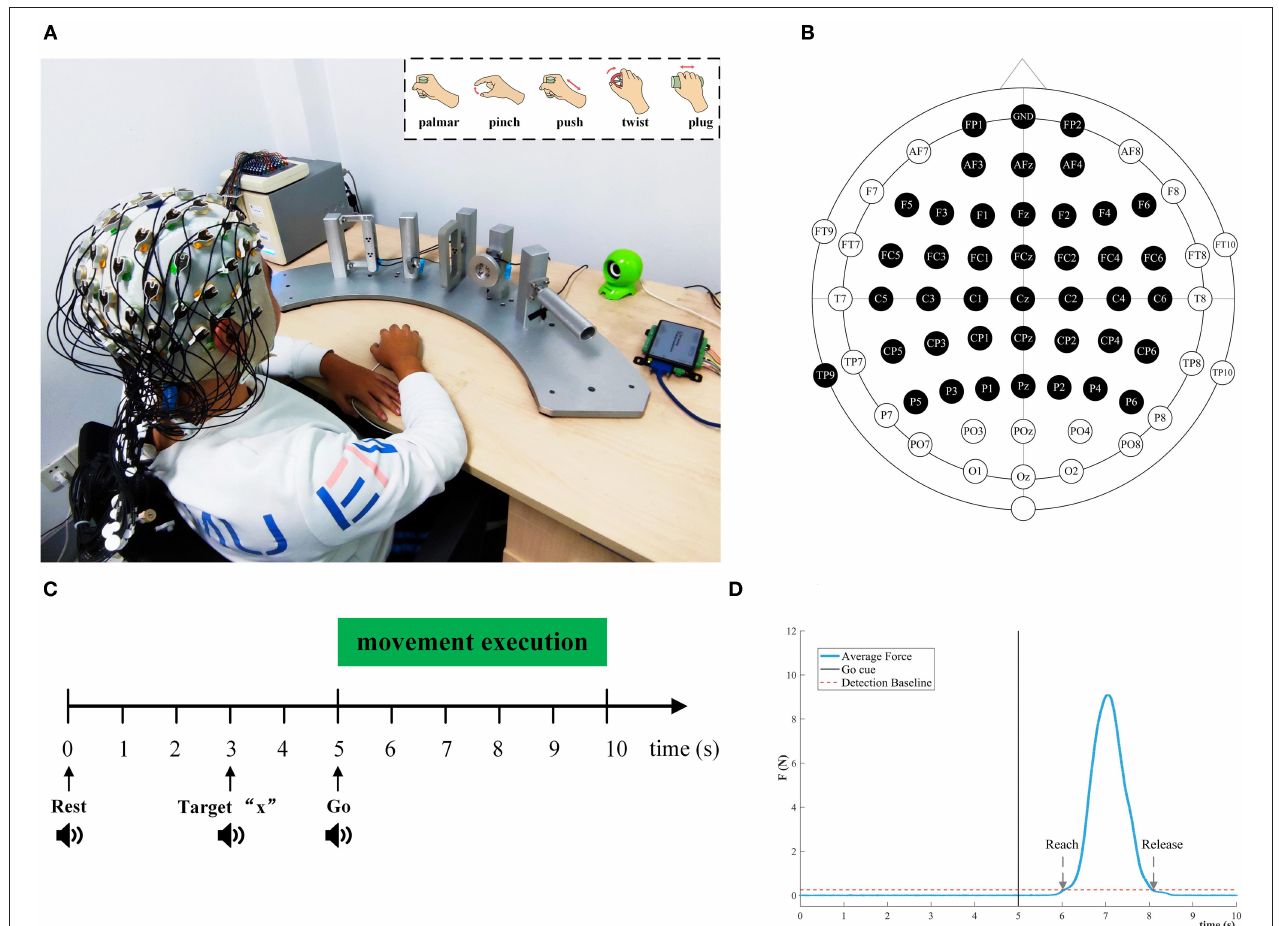
FIGURE 1 | Experimental setup and paradigm for reach-and-grasp tasks. (A) An experimental platform for subjects to execute reach-and-grasp actions. The subjects were seated in a comfortable chair. They performed reach-and-grasp actions according to the audio cue displayed by a loudspeaker. Top right: Five reach-and-grasp actions, namely, palmar grasp, pinch grasp, push grasp, twist grasp, and plug grasp. (B) The electrodes shown in black were selected in this study. (C) The experimental paradigm based on the audio cue. (D) The average force curve distribution of the pinch grasping for subject 3, and we calculated the reach and release timepoint of different grasping actions in this